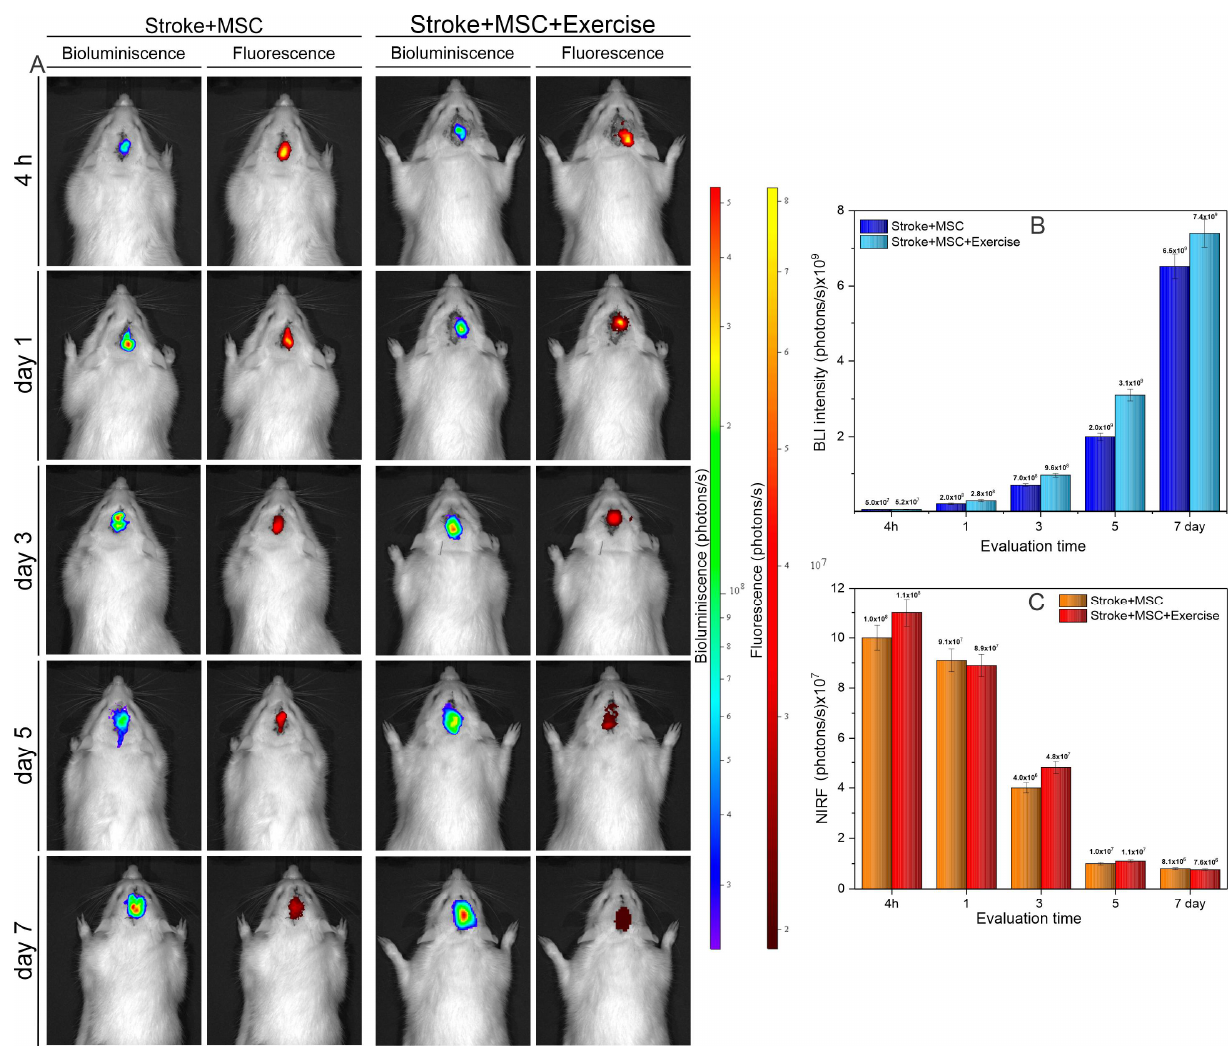
Figure 6. Evaluation of bioluminescence and fluorescence signal in the “stroke + MSC” (G3) and “stroke + MSC + exercise” (G5) groups, in the following conditions: 4 h and 1, 3, 5, 7, 14, and 21 days after the administration of MSC labeled with MNP. ( A ) BLI and NIRF signal representations in the “stroke + MSC” (G3) and “stroke + MSC + exercise” (G5) groups over the time with detectable signal for both techniques (until 7 day); ( B ) The graphic of the BLI signal intensity of groups analyzed over time; and ( C ) The graphic of the NIRF signal intensity of groups analyzed over